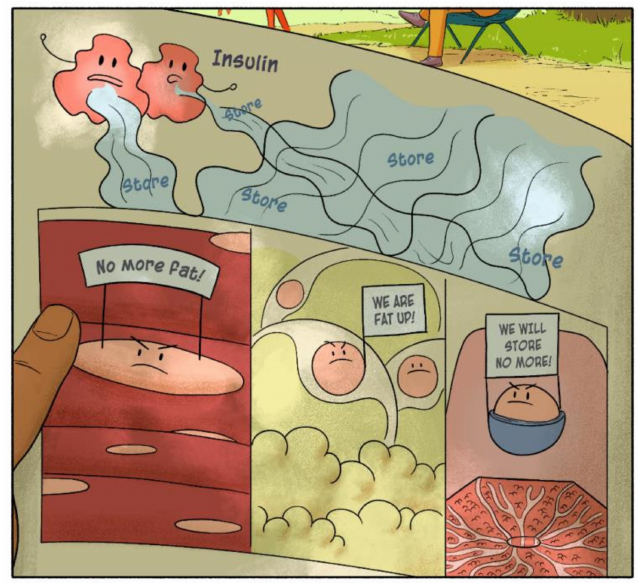
Figure 4. Anthropomorphizing biochemical elements such as molecules (Insulin) or cells/tissues (from left to right: muscle fat, liver) as a communication tool, in this case to convey the concept of insulin resistance using a “cells on strike” metaphor. See text for